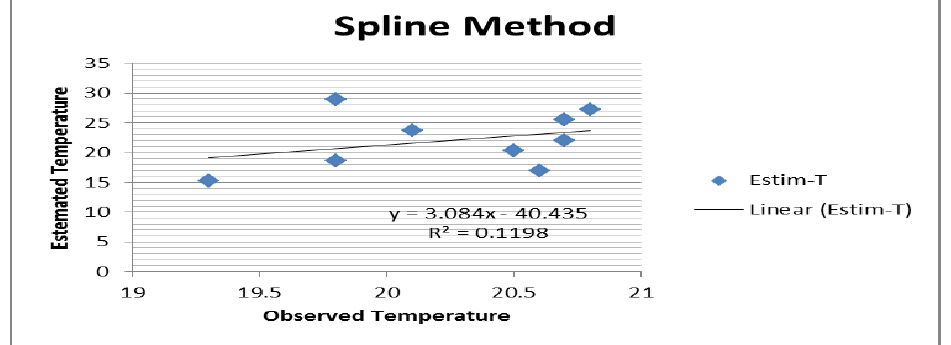
Fig.9: The Spline, comparison of estimated and observed mean Tmax.